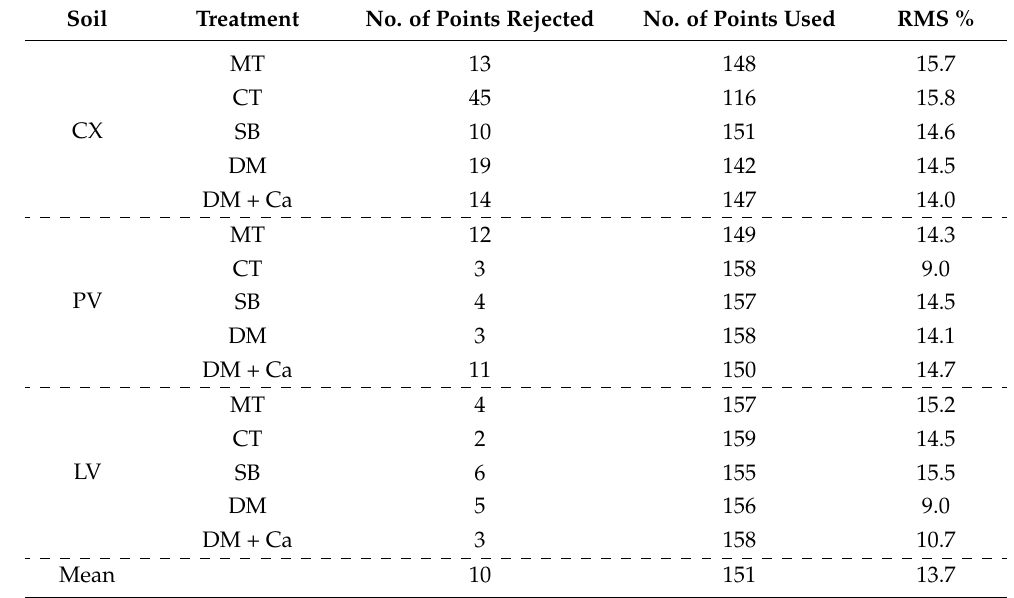
Table 2. Summary of the parameters of inversion and root mean square (RMS). Soil Treatment No. of Points